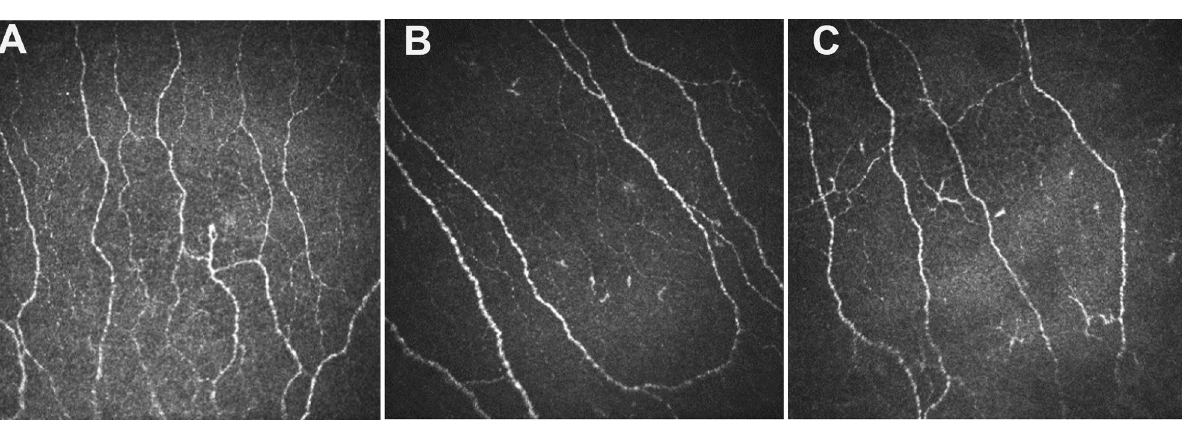
Figure 3. Corneal nerve morphology in a healthy control ( A ), patient with moderate-good pial collaterals ( B ) and patient with poor pial collaterals ( C